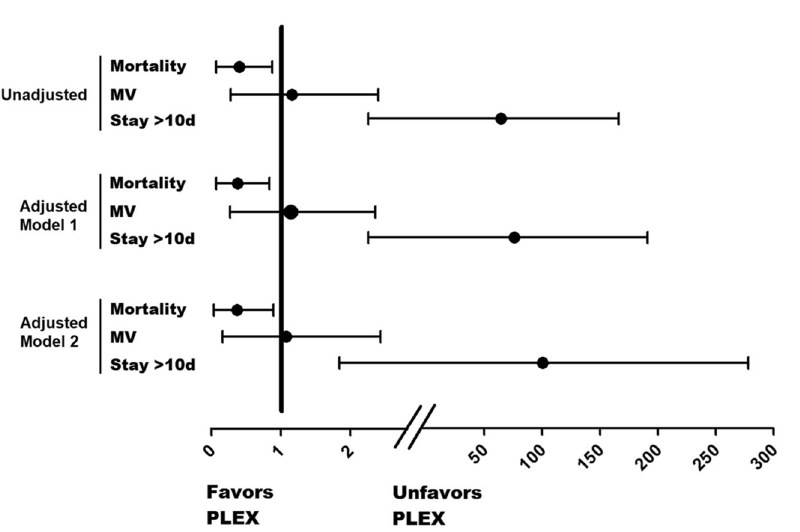
Figure 2. PLEX and risks of dead, mechanical ventilation and longer hospital stay. Forrest plot showing ORs corresponding to the effect of PLEX over dead, mechanical ventilation and longer hospital stay. Three models are shown, unadjusted (upper), adjusted model 1 (middle, adjusted by age and gender) and adjusted model 2 (lower, adjusted by age, gender and drug therapy including tocilizumab and